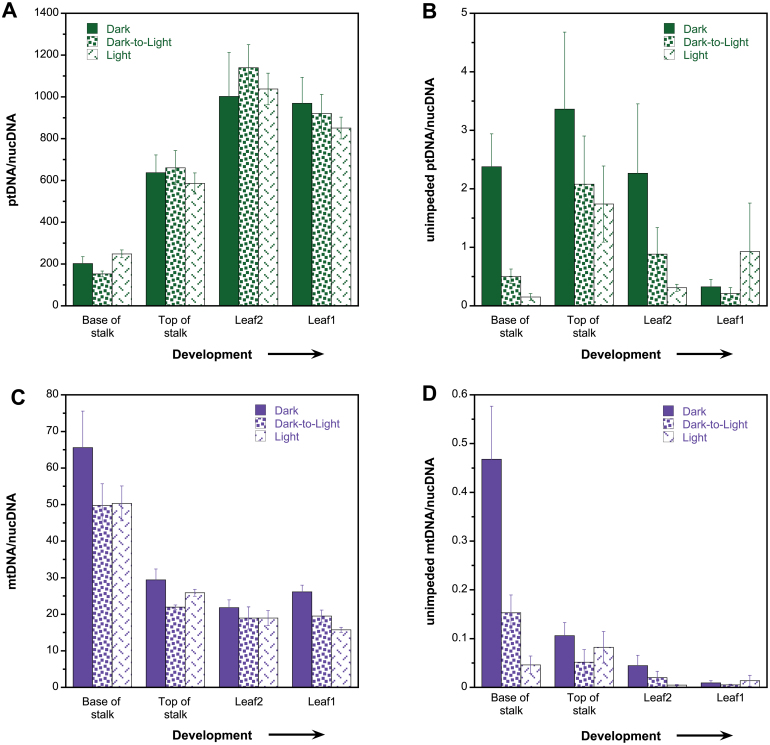
Plastid and mitochondrial genome copy number determined by qPCR and miPCR. Seedlings were grown under dark, dark-to-light, and light conditions and ttDNA was prepared from the base of stalk, top of stalk, leaf 2 and leaf 1 (four stages of development). Organellar genome copies per haploid nuclear genome were determined for ptDNA (A, B) and mtDNA (C, D). Real-time qPCR copies (A, C) were determined by normalizing short orgDNA copies with nuclear DNA copies. miPCR copies (B, D) were determined by normalizing long-PCR orgDNA copies with qPCR-determined nuclear DNA copies (see Materials and methods, and Table S1). The nuclear ploidy level was essentially constant at 2.8 during these stages of seedling development (Oldenburg et al., 2006). qPCR scored most of the orgDNA copies, while miPCR scores only orgDNA copies without discontinuities or DNA lesions. Statistical analyses (ANOVA and Tukey’s HSD) were performed to compare differences between growth conditions and between developmental stages (tissues). In addition, individual sample comparisons were performed between growth conditions for each tissue and between the tissues for each growth condition. qPCR-determined copy differences were not significant for growth conditions for both orgDNAs. The developmental stages S1:S2, S1:L2, S1:L1, S2:L2, and S2: L1 had a value of P<0.05 for both orgDNAs. qPCR-determined copy differences were not significant for individual sample comparisons and growth conditions for ptDNA; for mtDNA, S2 grown in dark and dark-to-light, L1 grown in dark and dark-to-light, and L1 grown in dark and light conditions had a value of P<0.05. For individual sample comparisons and developmental stage, dark-grown S1:S2, S1:L2, and S1:L1, dark-to-light-grown S1:S2, S1:L2, and S1:L1, and light-grown S1:S2, S1:L2, S1:L1, S2:L2 (ptDNA only) and S2:L1 (mtDNA only) had P<0.05 for both orgDNAs. miPCR-determined copy differences were significant between dark and dark-to-light (not for mtDNA) and dark and light conditions for both orgDNAs, when growth conditions were compared. The developmental stages S1:S2 (ptDNA only), S1:L2 (mtDNA only), S1:L1(mtDNA only), S2:L2 (mtDNA only), and S2:L1. L2:L1(ptDNA only) had P<0.05 for both orgDNAs. For individual sample comparisons and growth conditions, only S1 grown in dark and light had P<0.05 for both orgDNAs. For individual sample comparisons and developmental stages, dark-grown S2:L1, dark-to-light-grown S2:L1, and light-grown S1:S2 had P<0.05 for ptDNA, and for mtDNA, dark-grown S1:S2, S1:L2, S1:L1, and S2:L1, dark-to-light grown S1:L2 and S1:L1; and light-grown S2:L2 and S2:L1 had P<0.05. All significant comparisons are also provided in Supplementary Tables S3–S6. Error bars represent standard errors determined for five biological replicates.